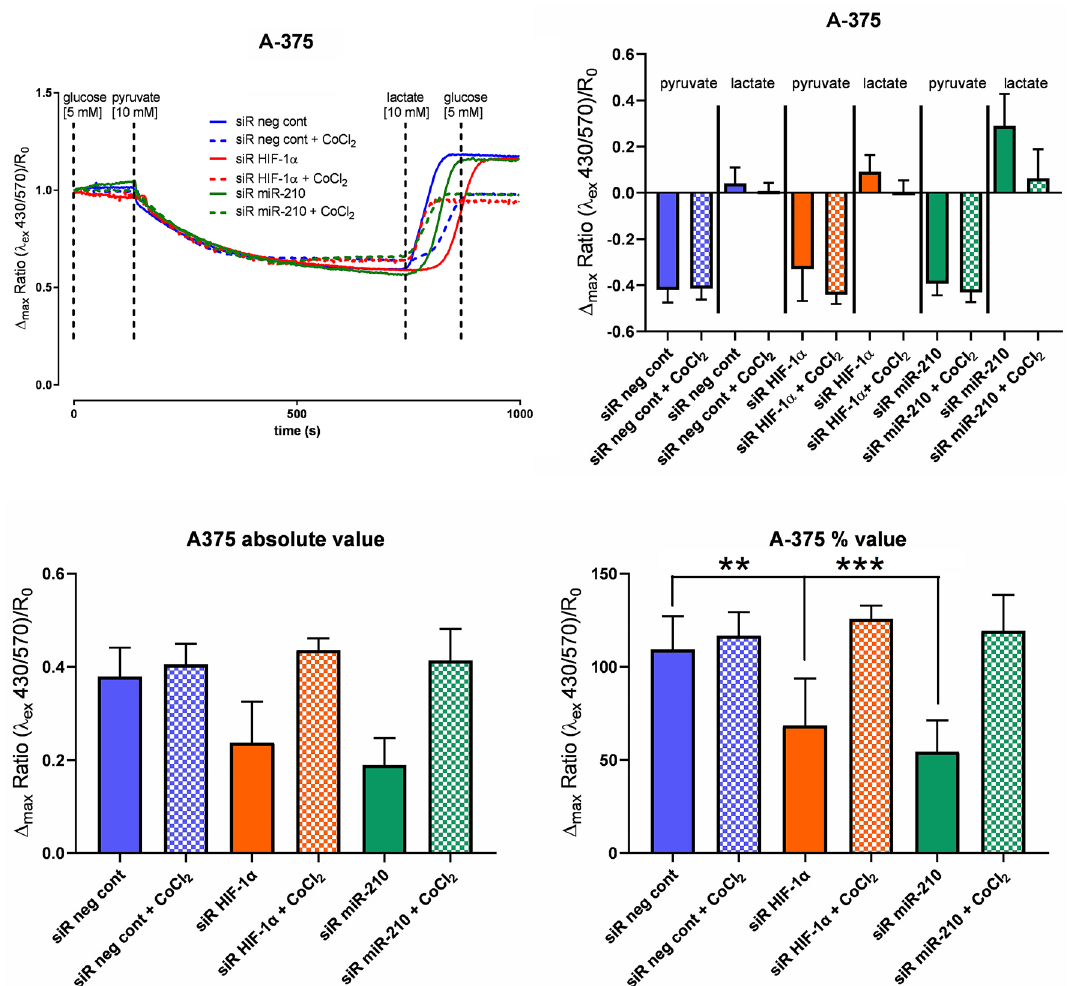
Figure 3. Cytosolic NADH/NAD + ratio; the level of free NADH decreased in normoxia and slightly decreased in hypoxia (significant change with P value < 0.05 marked with *, P value < 0.01 marked with **, P value < 0.001 marked with